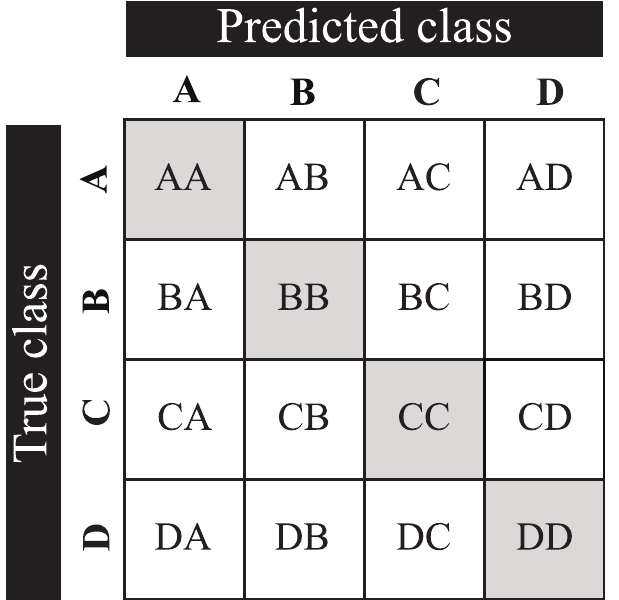
Fig 6. Confusion matrix for multi-class classification problem, with A, B, C and D as classes. The elements located on the diagonal of the matrix represent the correct predicted number of samples; the remaining elements represent the instances incorrectly classified as class A, B, C, or